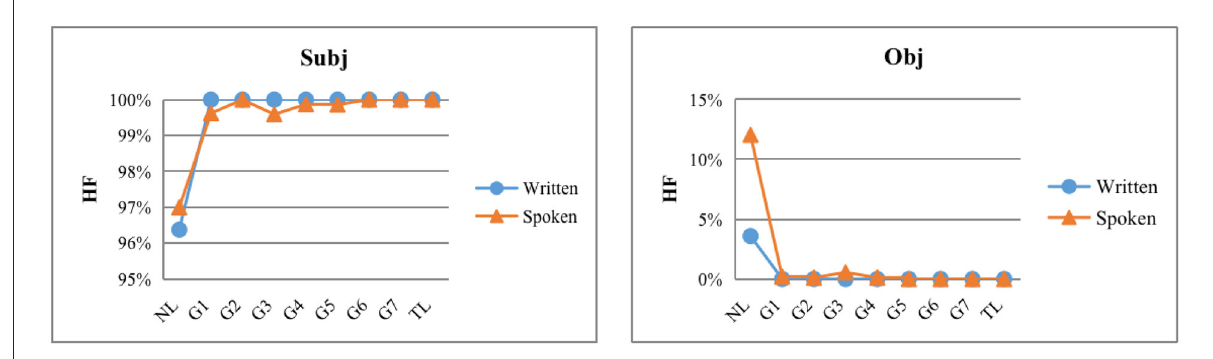
FIGURE4 HF dependency direction distributions of subjects and objects at each level and in contrastive